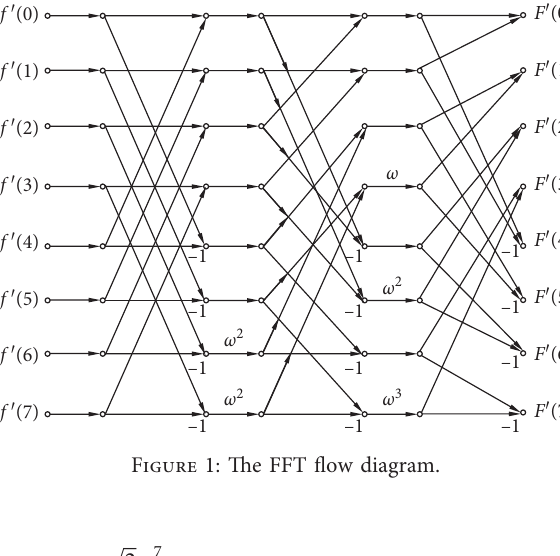
Figure 1: The FFT flow